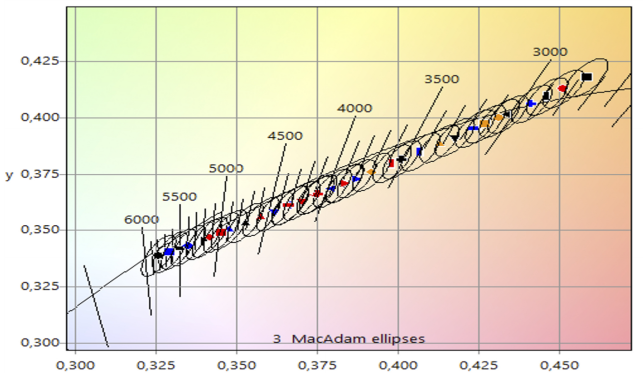
Figure 11. Distribution of some midpoints of the measurements of the training phase in the CIE 1931 graph is shown as a function of different input power for the warm and cool channel; the 3-step MacAdams represent the uncertainty of the mathematical